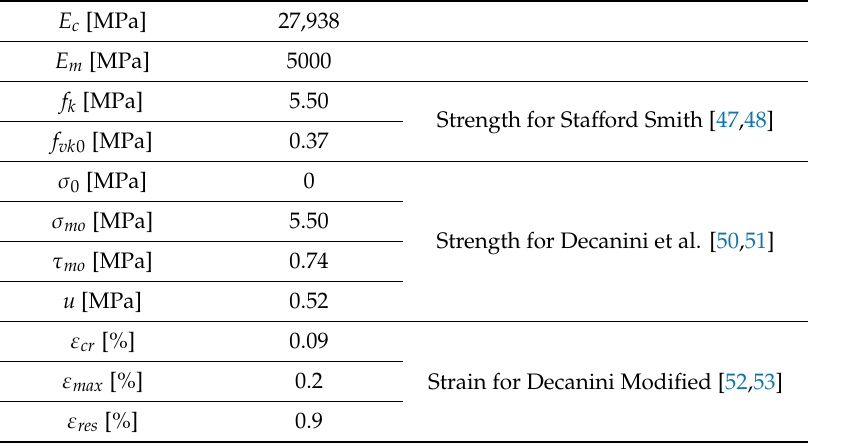
Table 6. Panel material properties for selected models.